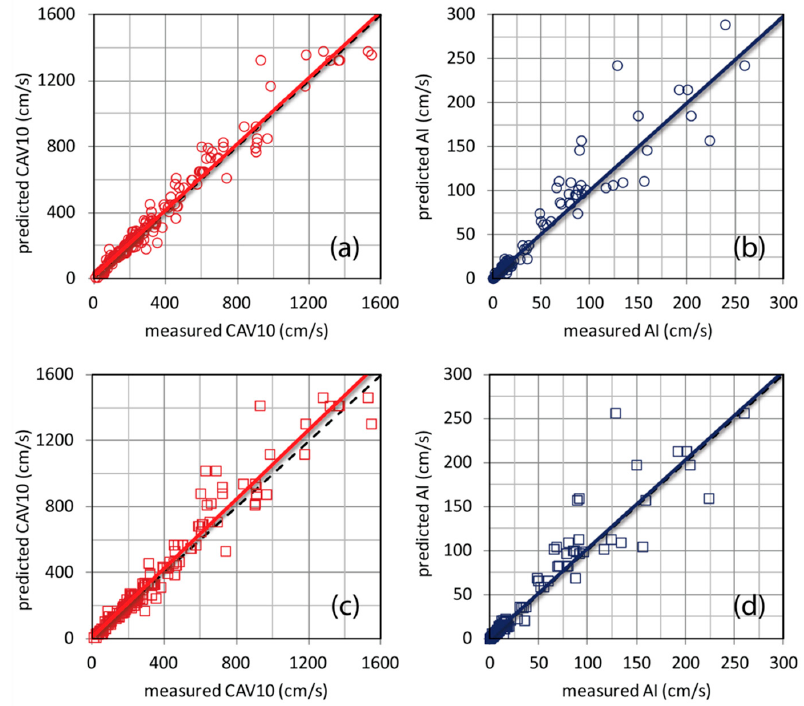
Figure 5. Cross-validation between measured and predicted values through kriging ( a , b ) and cokriging ( c , d ) methods with the exponential fitting model for the M W 6.5 Norcia earthquake. For the cokriging method, CAV10 and AI were selected alternatively as primary and the other one with PGA and PGV as secondary variables.